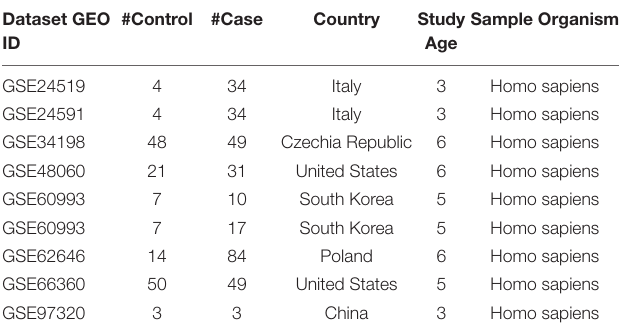
TABLE 1 | The nine myocardial infarction expression datasets selected for meta-analysis. Dataset GEO